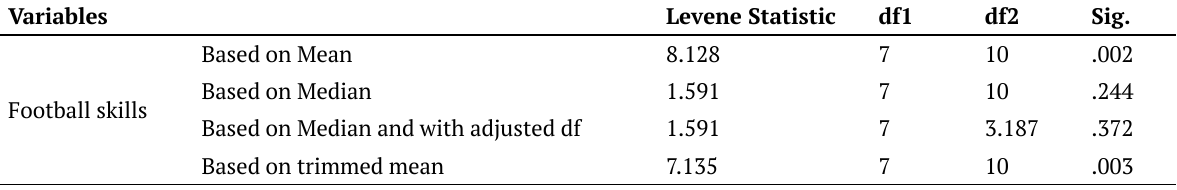
Table 7. The Linearity Test’s Result